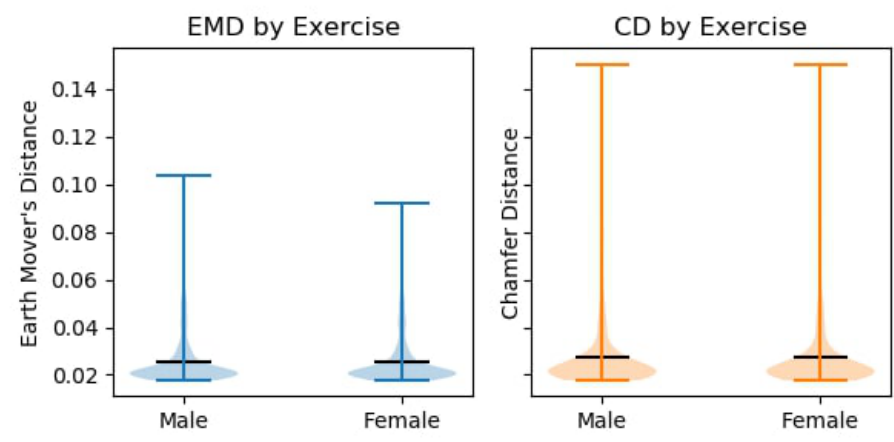
Figure 10. Reconstruction quality breakdown of the subjects’ by